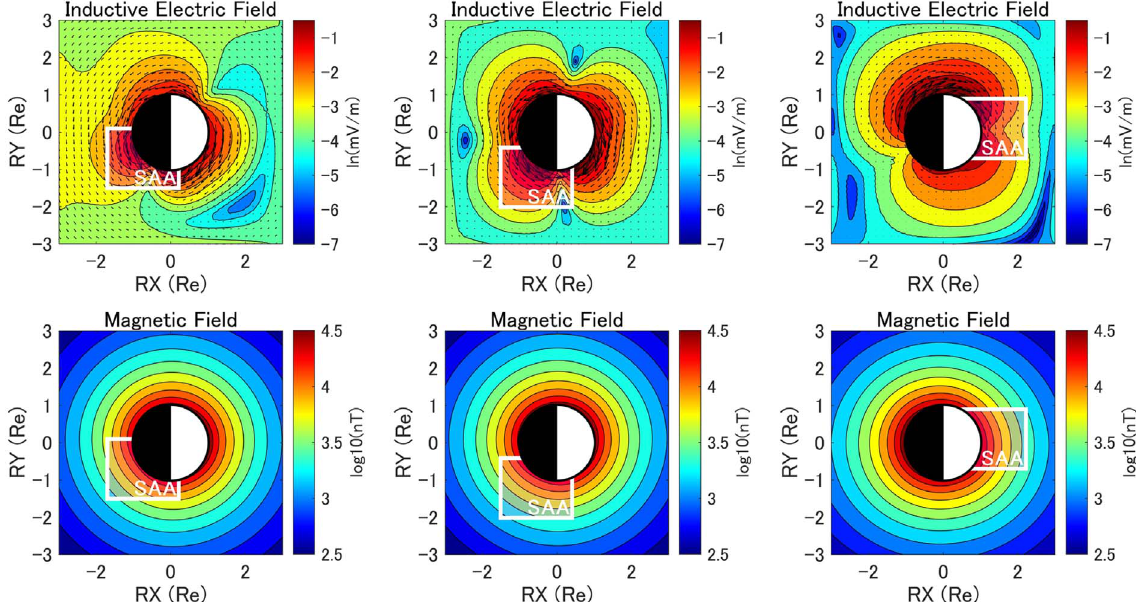
Fig. 2. The top three panels visualize the equatorial contour plot of the magnitude of the inductive electric fi eld with its fi eld directions and the equatorial magnetic fi eld component B z (TS05 + IGRF) at 07:00, 10:00 and 16:00